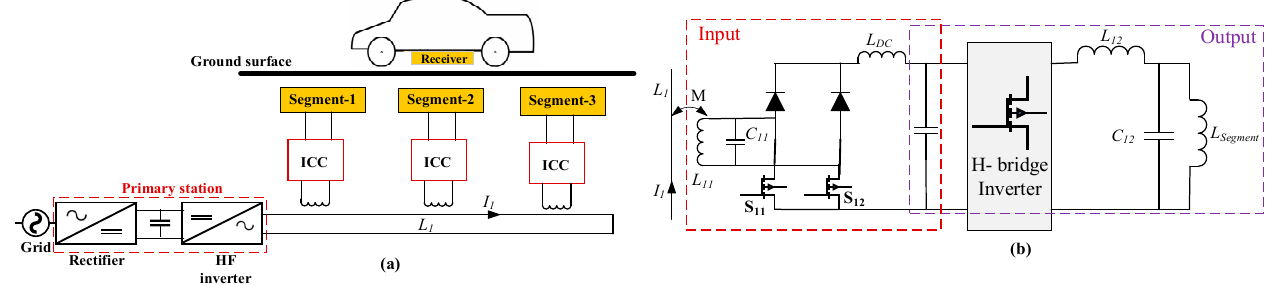
Figure 10. Schematics of ( a ) doubled coupled system and ( b ) intermediate coupler circuit (ICC). A double-spiral repeater was used in [93] to improve the power transmission efficiency, increase the transmission distance, and increase the variation in the linear